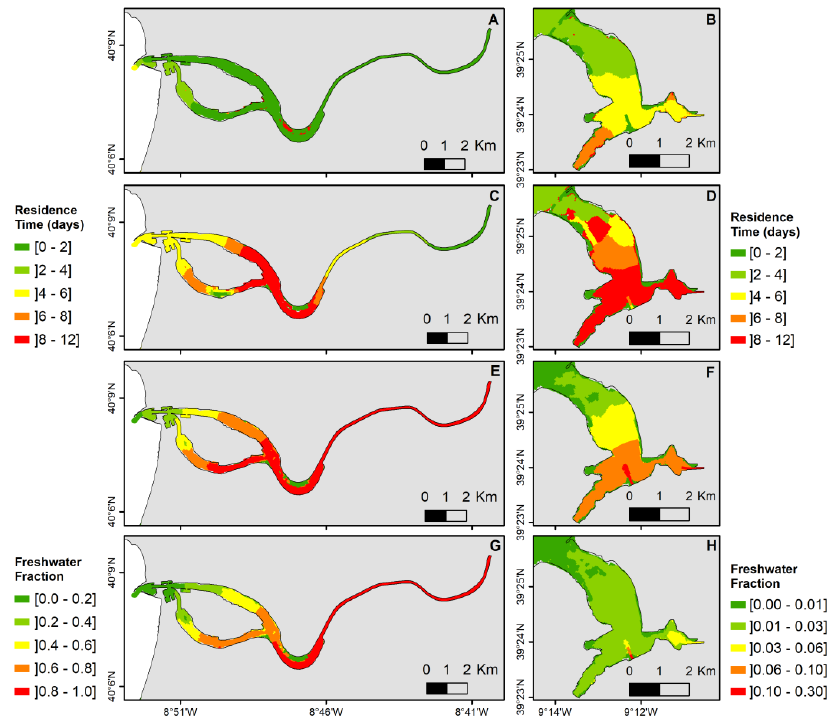
Figure 8. Residence time (days) for winter ( A , B ) and for summer ( C , D ) and freshwater fraction for winter ( E , F ) and summer ( G , H ) for Mondego Estuary (left) and Ó bidos Lagoon